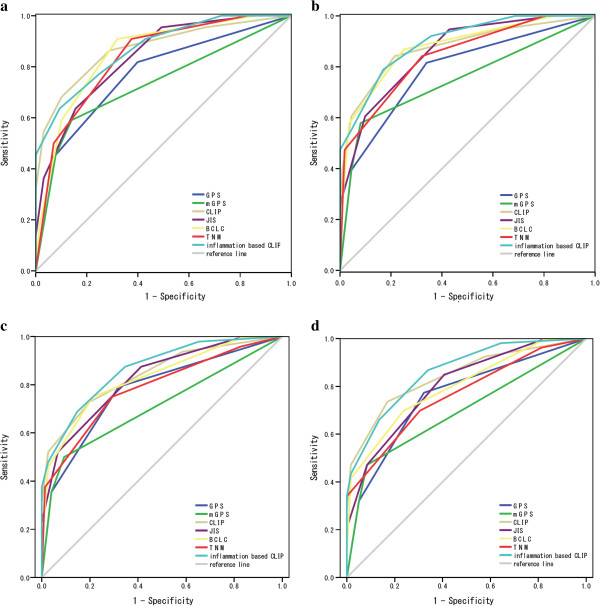
Comparisons of the area under the receiver operating curve for survival status between scoring systems at 6 month (a), 12 month (b), 18 month (c), and 24 month (d).